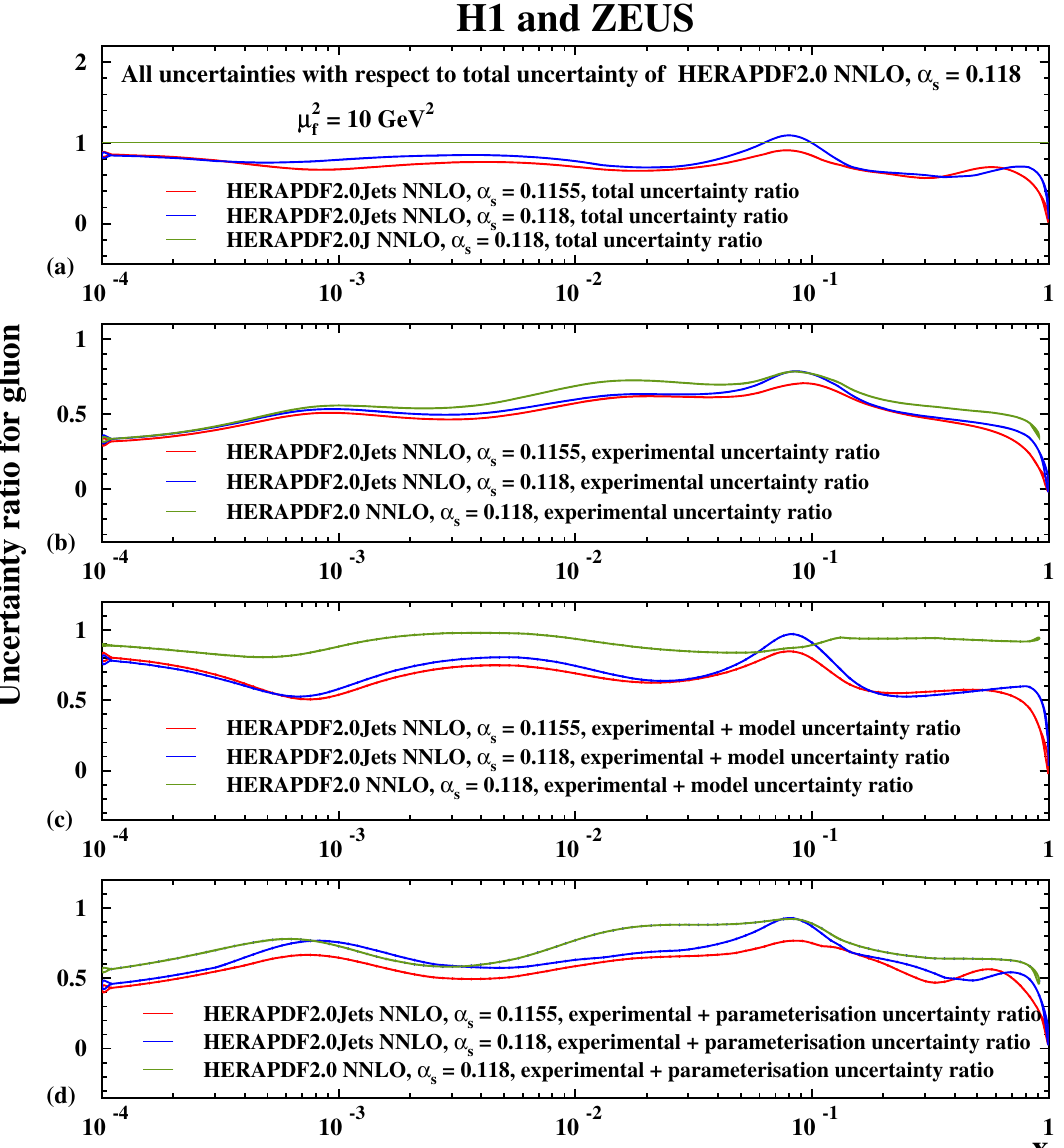
) = 0 . 118 and Z = 10GeV f